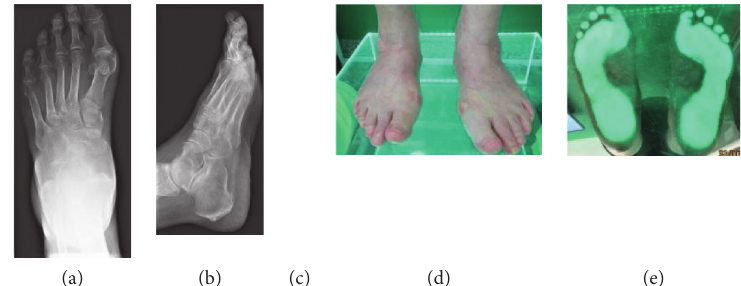
Figure 7: (a–e) Results of imaging tests (X-ray) and podoscopic tests: patient no. 8. (a) Dorsal-plantar X-ray: hallux valgus, subluxation of sesamoid bones, and overloaded cuneometatarsal joint. (b) Diagonal foot X-ray (lateromedial): enthesopathy of the plantar fascia and Achilles tendon, numerous calcifications, and overloads in the upper ankle joint. (c) Posterior picture: ankle joint and hindfoot evaluation. (d) Anterior picture of the feet: assessment of toe positioning and deformation. (e) Plantar photo on the podoscope: assessment of plantar part of the foot, height measurement of the longitudinal arch.